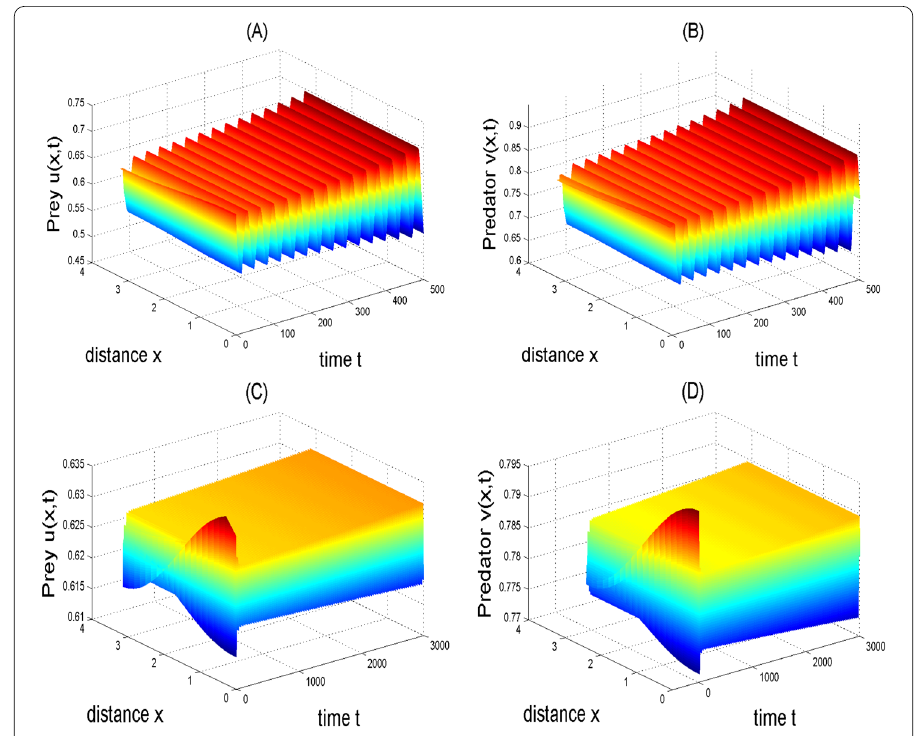
Figure 2 There exists unstable spatially homogenous periodic bifurcating from the positive equilibrium ( u ∗ , v ∗ ) = (0.6250,0.7813) of (1.2) when τ = 6.85 > 6.8222. Here we set parameter values d 1 = 0.2, d 2 = 1, δ = 2, α = 0.05, β = 0.3, h = 0.8, c = 0.1. ( A )–( B ) The initial value ( u ( x ,0), v ( x ,0)) = (0.62 + 0.05cos x ,0.78 + 0.05cos x ); ( C )–( D ) The initial value ( u ( x ,0), v ( x ,0)) = (0.62 + 0.05sin x ,0.78 + 0.05sin x